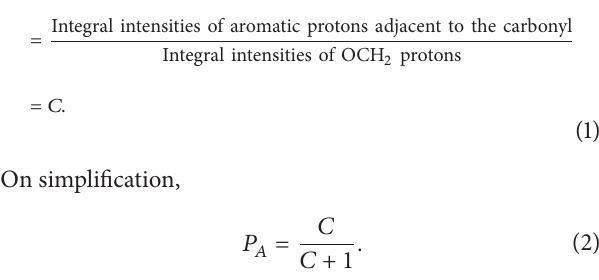
were attributed to the ester carbonyl stretching of APMA and EMA units, respectively. Besides, the ketone carbonyl stretching shows absorption band at 1685 cm